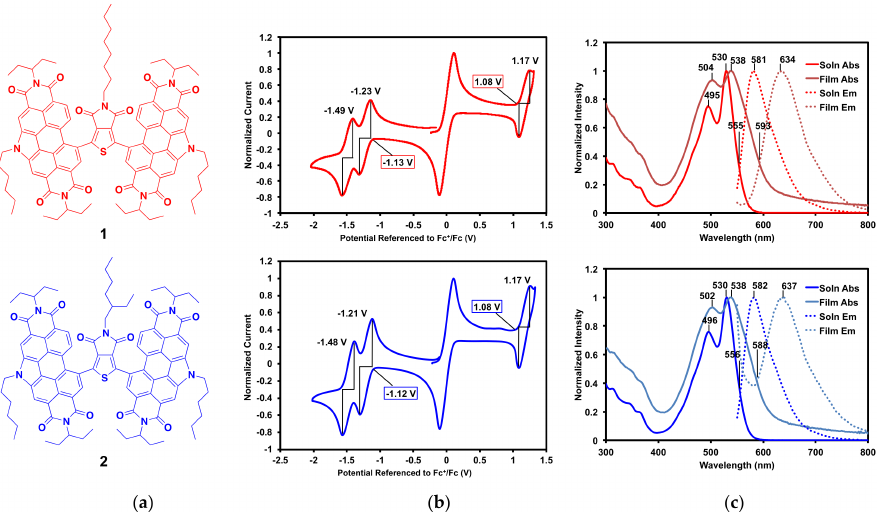
Figure 3. ( a ) Compounds 1 and 2 ; ( b ) cyclic voltammograms (with ferrocene internal standard) with onset potentials and E 1/2 potentials shown; ( c ) solution and thin film absorption and emission profiles with λ max and intercept between absorption and emission profiles, λ int , shown. Emission spectra were recorded with excitation at 530 nm. Table 2. Summary of experimental optoelectronic properties of compounds 1 and 2